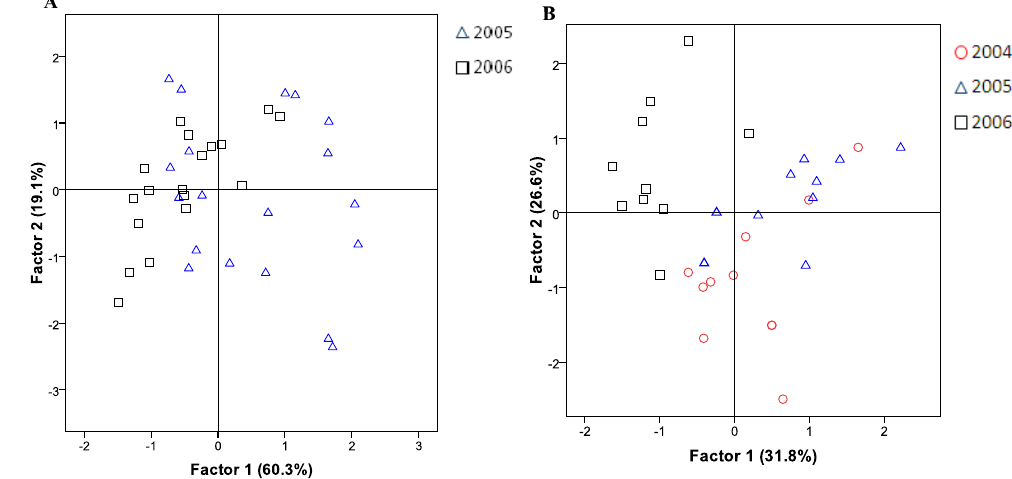
Figure 1. Principal components analysis using chemical composition data (A – 2005 and 2006) and fatty acids data (B – 2004 to 2006) of commercial stoned table olives “ alcaparras” . The PCA factors explain 79.4% and 58.4% (A and B respectively) of the total